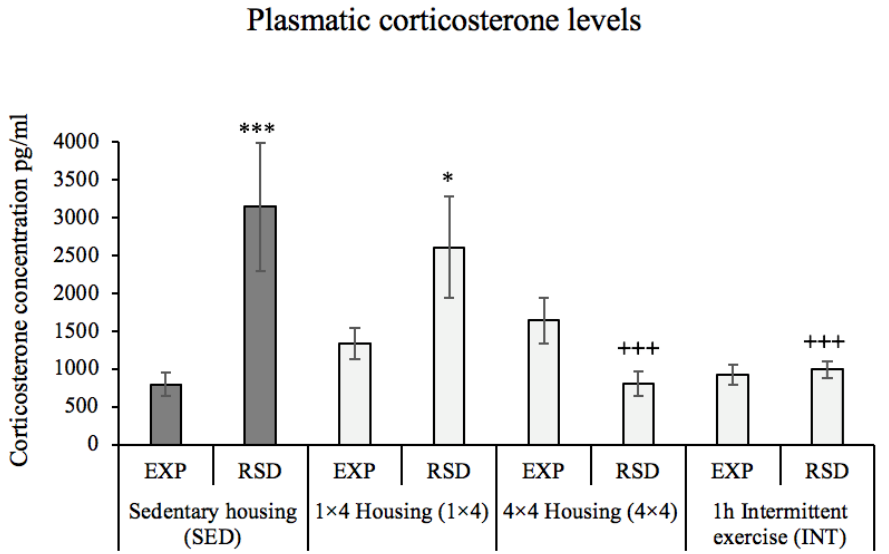
Figure 4. Physical activity in the form of voluntary wheel running modulates the increase in plasmatic corticosterone levels after an episode of social defeat. Mice in Study 1 were randomly assigned to the following groups, according to physical activity condition: sedentary housing (SED – EXP n = 9; SED – RSD n = 9); one activity wheel per cage (1 × 4-EXP n = 8; 1 × 4-RSD n = 8); four activity wheels per cage (4 × 4-EXP n = 8; 4 × 4-RSD n = 8); regimen of intermittent exercise (INT – EXP n = 7; INT – RSD n = 8). Data are presented as mean values of corticosterone (pg/mL in plasma) ± SEM; * p < 0.05; *** p < 0.001 significant difference in corticosterone levels with respect the corresponding EXP group; +++ p < 0.001 significant difference in corticosterone levels vs. SED – RSD.